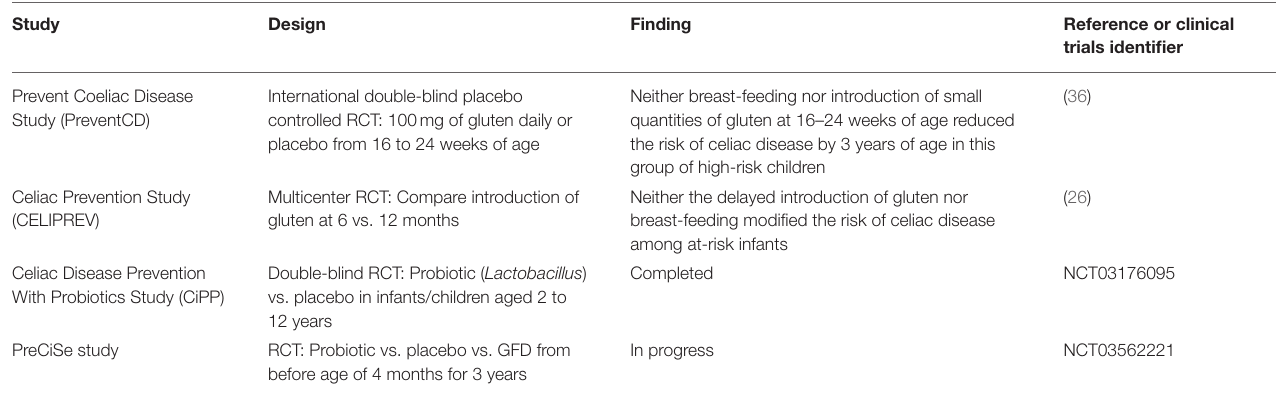
TABLE 2 | Prospective trials in infants/children looking at factors impacting celiac disease development. Study Design